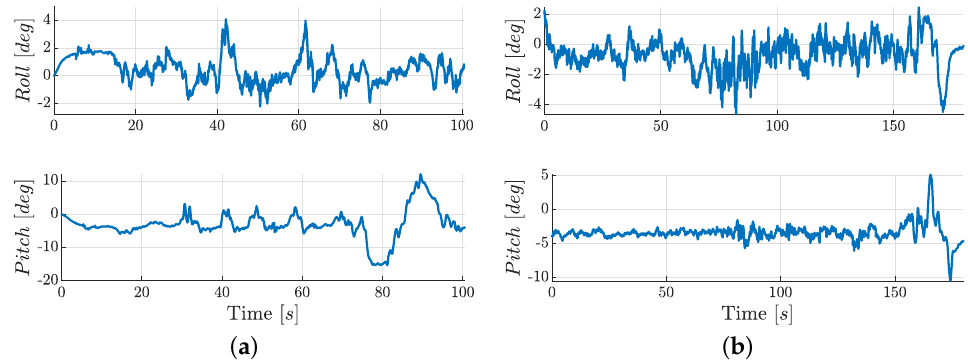
Figure 11. Roll and pitch orientation angles in the circuit and offroad paths. ( a ) Circuit path. ( b ) Offroad